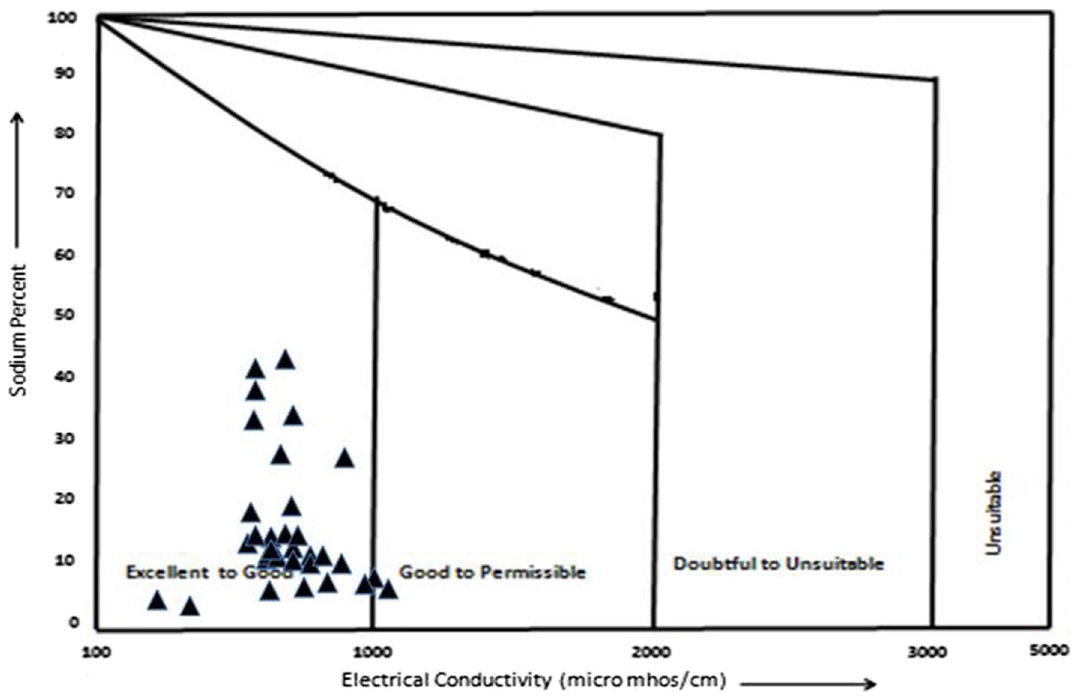
Fig. 36 Wilcox diagram (pre-monsoon)